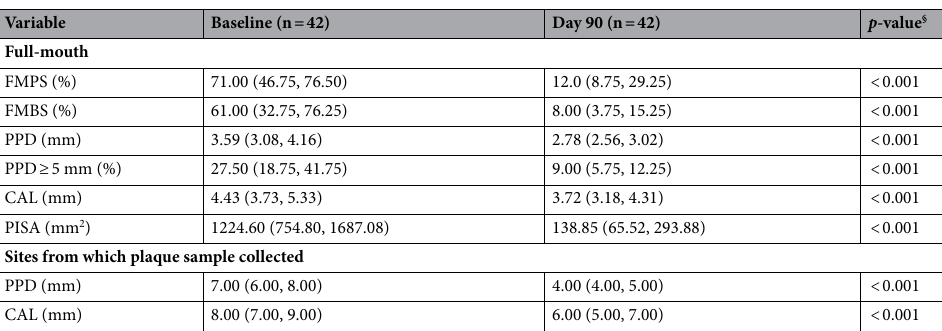
Table 1. Comparison of periodontal parameters at baseline and day 90 (n = 42). Data represent full-mouth and the site from which subgingival plaque was harvested. Data are displayed as medians (Q1, Q3). FMPS; full- mouth plaque score, FMBS; full-mouth bleeding score, PPD; probing pocket depth, CAL; clinical attachment level, PISA; periodontal inflamed surface area. § p -values refer to Wilcoxon signed rank